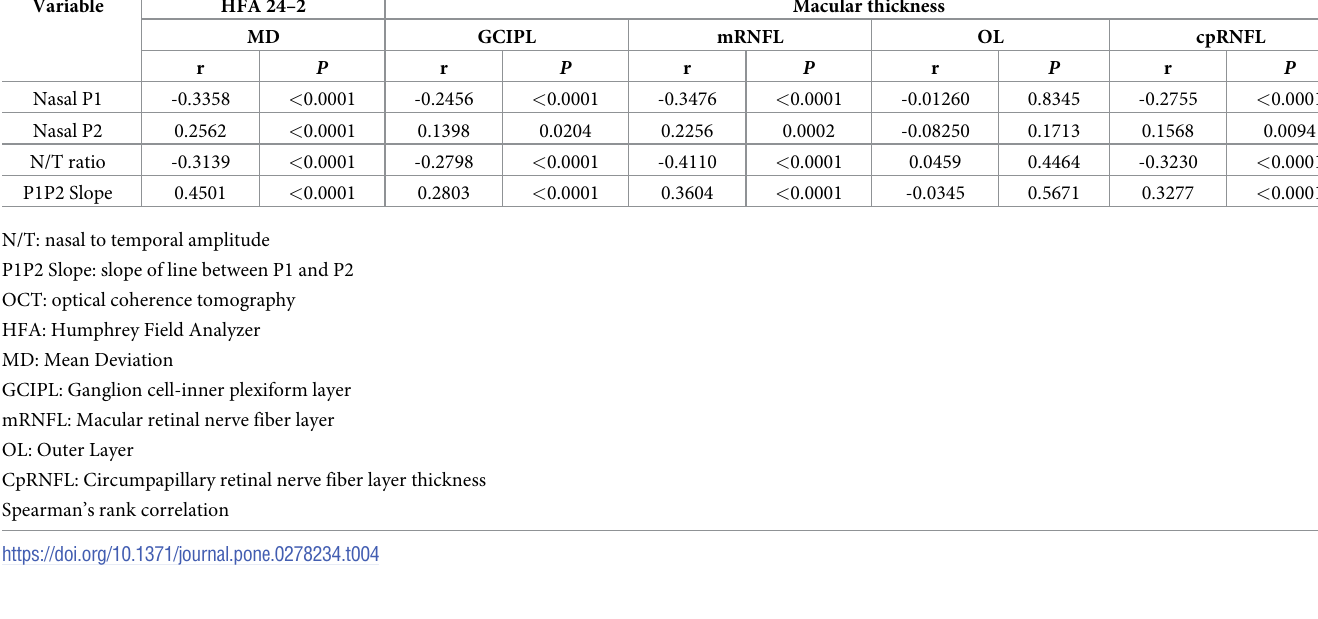
Table 4. Correlation between N/T amplitude ratio of second order kernel and the slope of the line and MD of Humphrey Central 24–2 program. OCT findings are also presented.